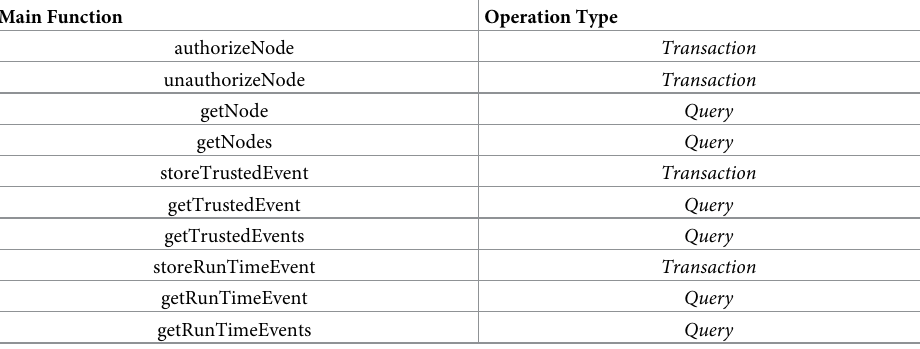
Table 3. Main smart contract functions of the system.